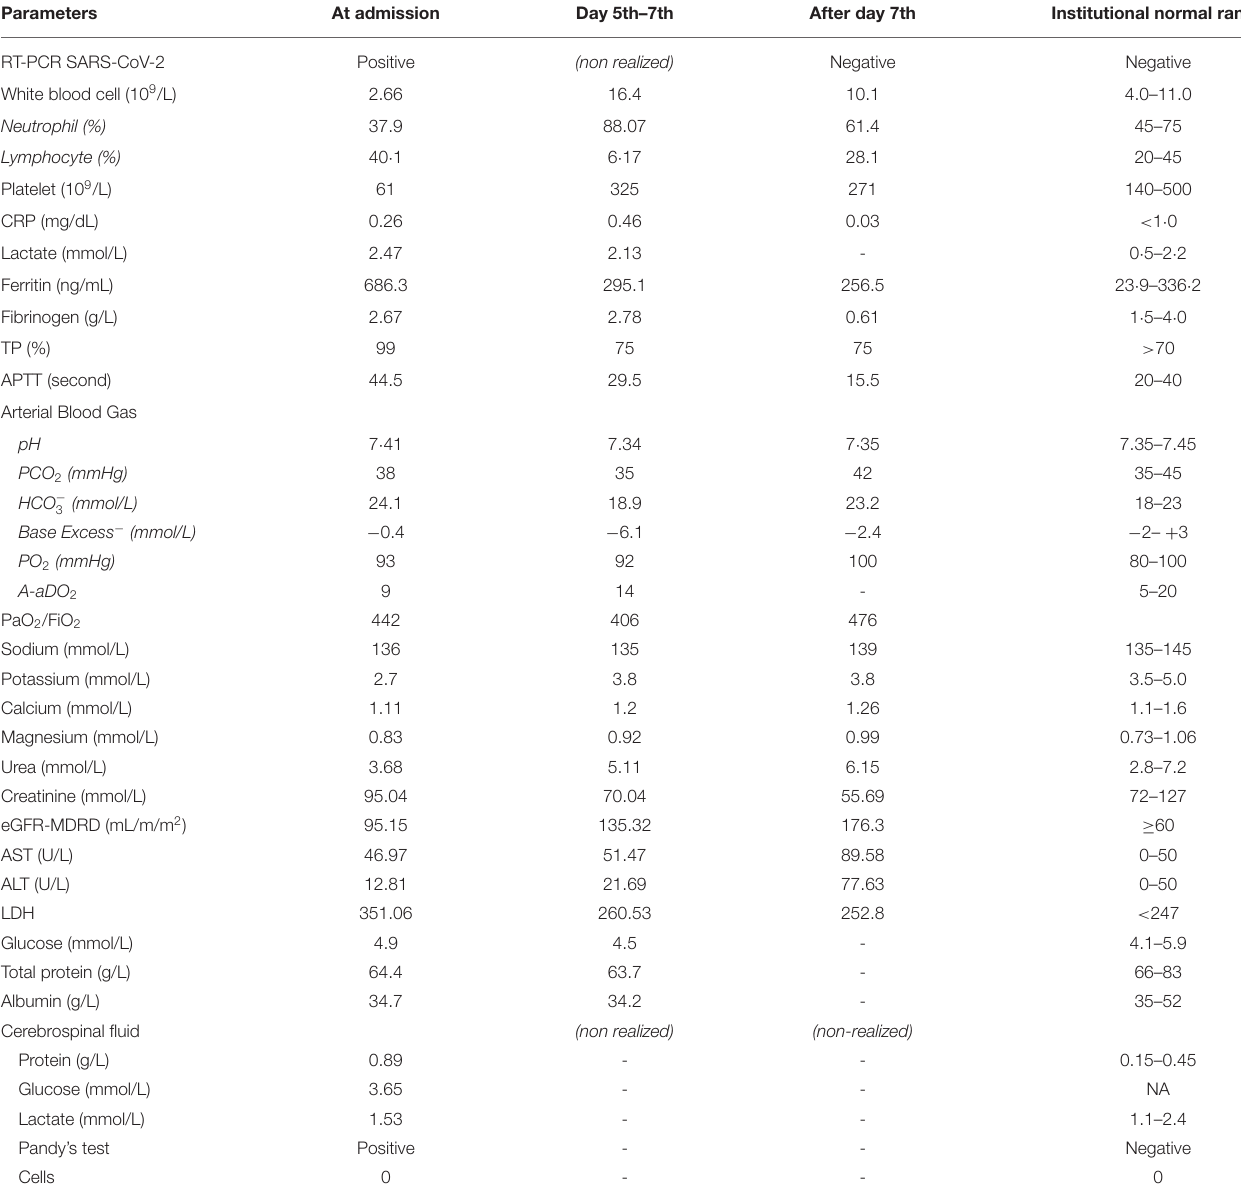
TABLE 1 | Characteristics of laboratory parameters of reported